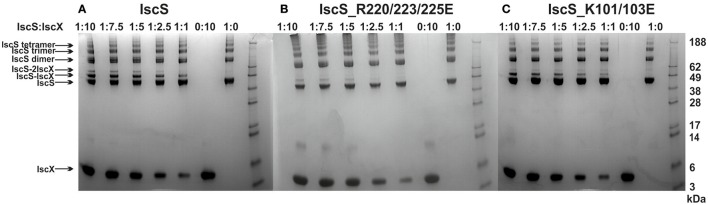
Cross-linking experiments to identify the interacting sites on IscX and IscS using different relative concentrations of IscS and IscX. (A) Experiments using wild-type IscS (8 μM) and IscX at molar ratios 1:10, 1:7.5, 1:5, 1:2.5, and 1:1 from left to right. The last two lanes on the right are the controls carried out using isolated IscS and IscX. As expected the IscS dimer disassembles in SDS and runs as a monomer of ca. 45 kDa. (B) The same as in A but with the IscS_R220/223/225E mutant. (C) The same as in A but with the IscS_K101/105E mutant. The markers are indicated on the right.